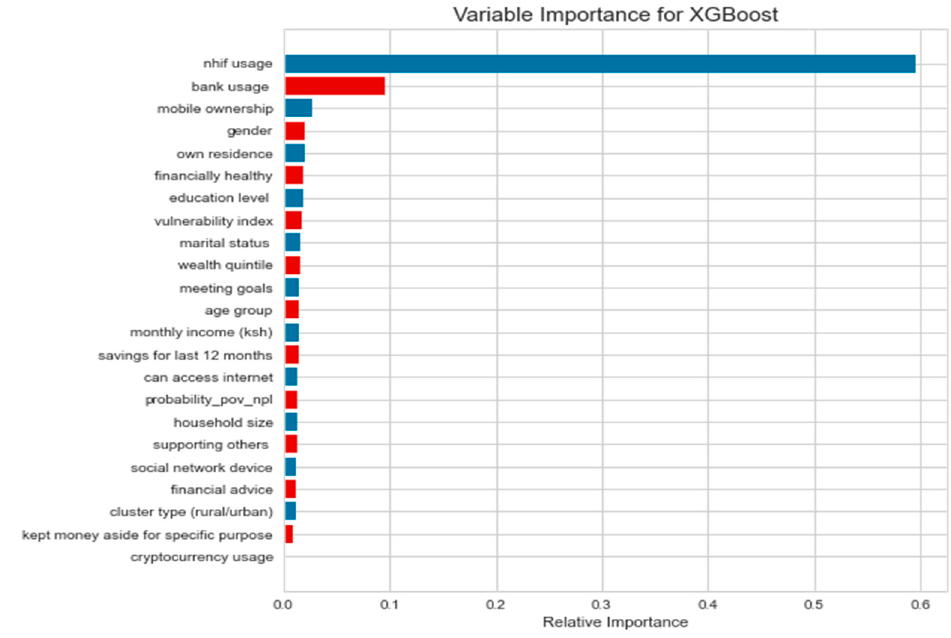
Figure 8. Feature importance from XGBoost.